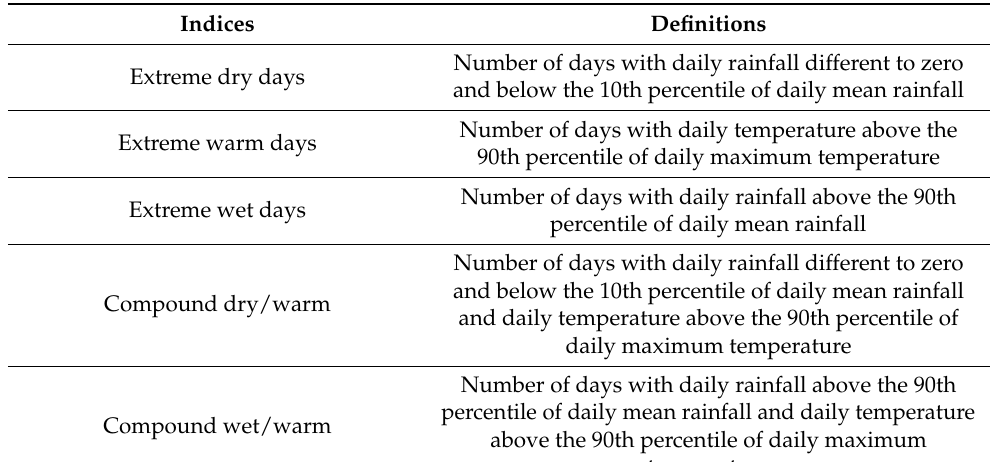
Table 3. Definitions of the five extremes used in this study [28–31,34,38,40,43,44,49,68–74]. Indices Definitions Number of days with daily rainfall different to zero Extreme dry days Extreme warm days Extreme wet